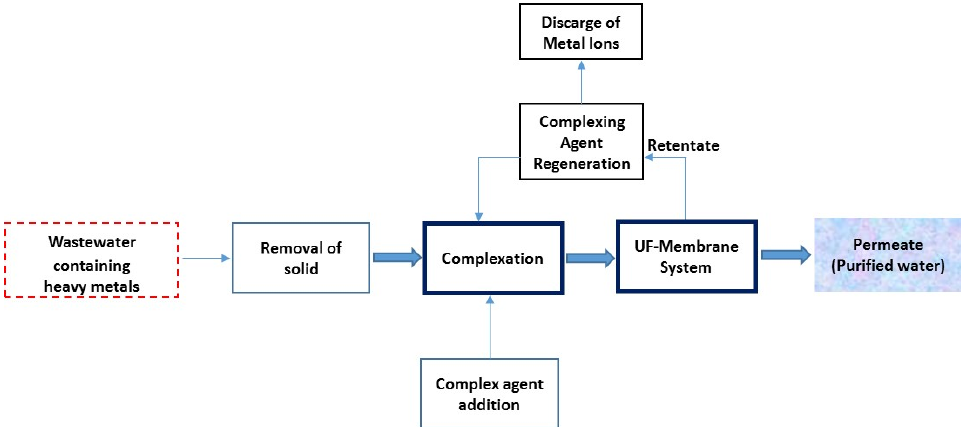
Figure 1. Scheme of the complexation-UF hybrid process, adapted from [33].